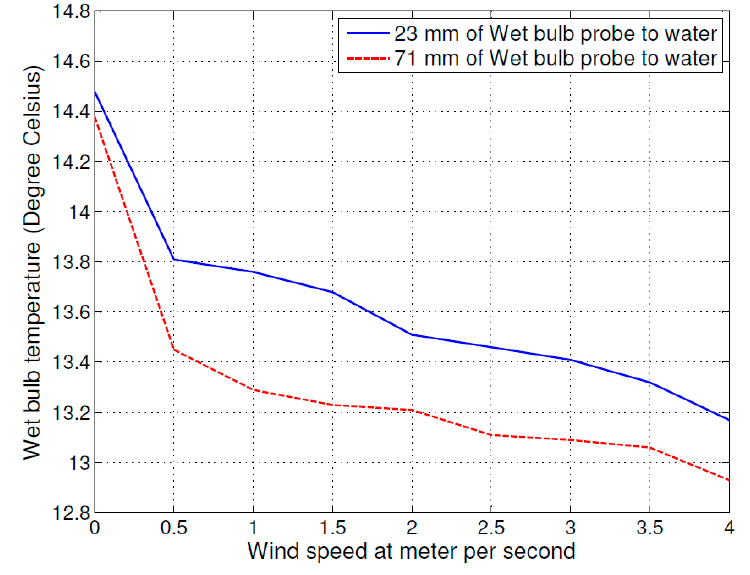
Figure 2. The relation between the air flow speed and wet bulb temperature (cloth size: 63 mm × 122 mm).